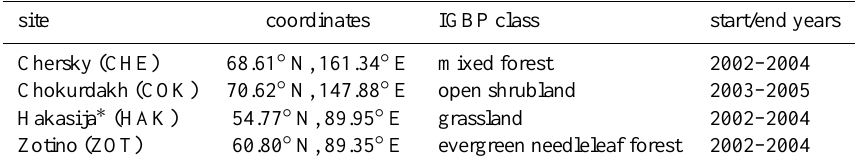
Table 3. Flux tower sites from the LaThuile data set (Baldocchi, 2008) used in this study. Site Hakasija consists of records from 3 sub-sites which all fall within the same RCN model grid. Each sub-site is represented with a different symbol in Figs. 2c, 3c, 4c. GPP and ER in the La Thuile data set are calculated using methodologies described in Reichstein et al. (2005).